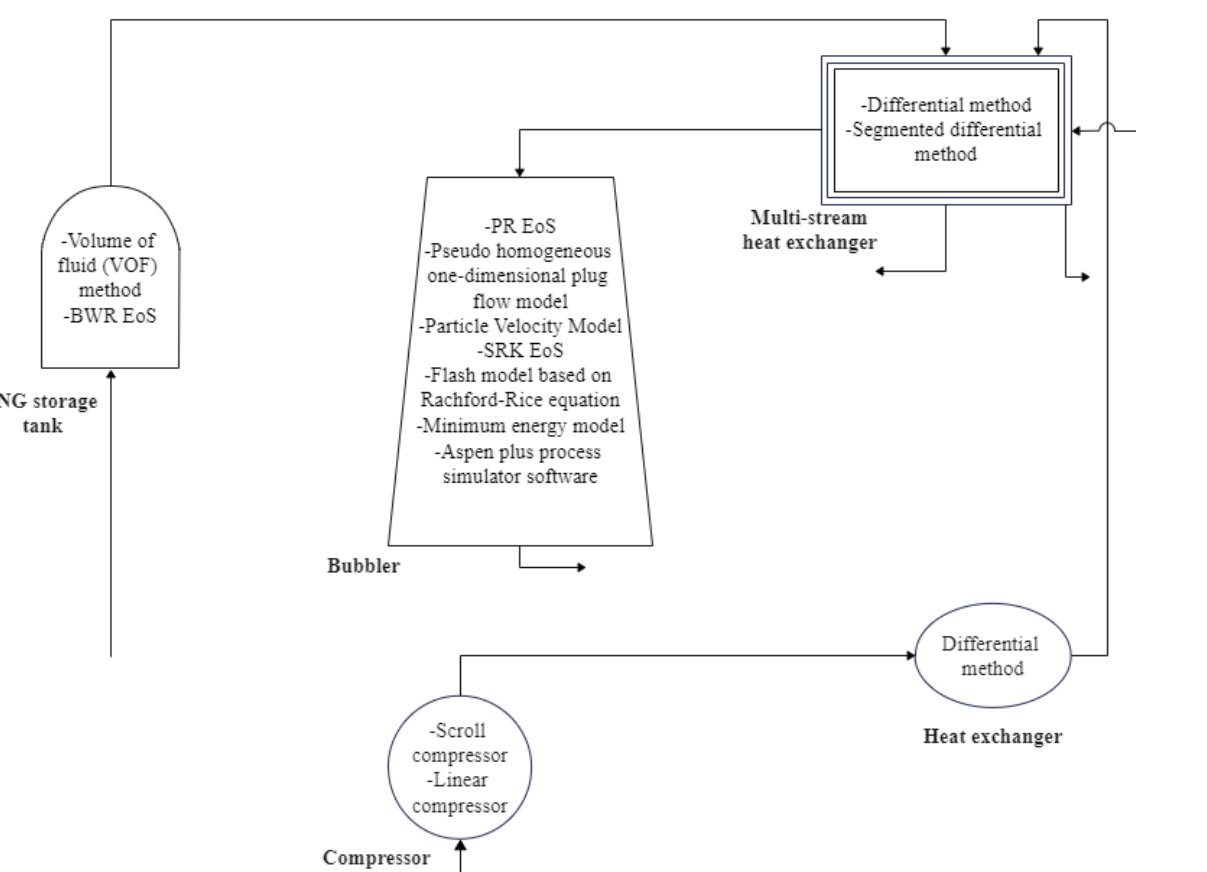
Figure 3. The models for each component and their applications in the CCC process.